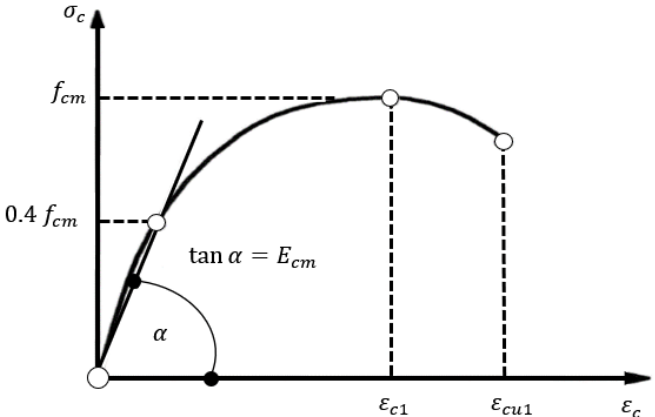
Figure 3. Schematic the stress–strain representation of the concrete material, Eurocode 2